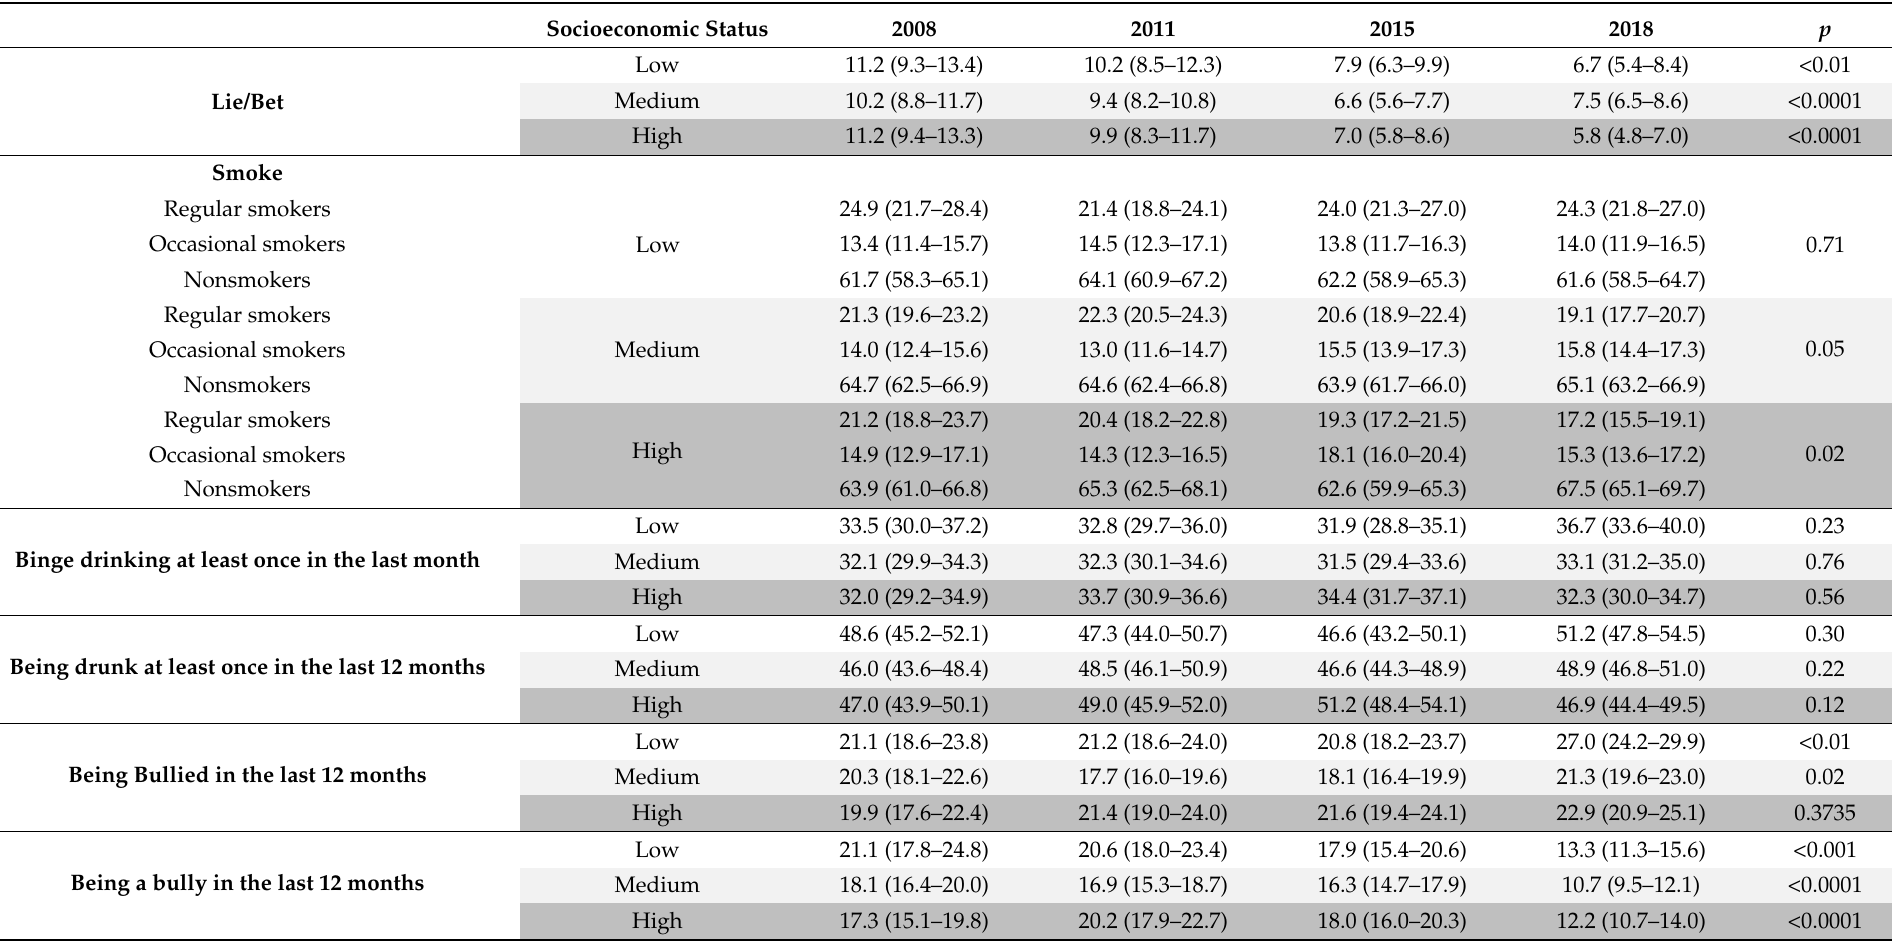
Table 5. Trends of the prevalence of health risk behaviors and health conditions by socioeconomic status (survey waves 2008, 2011, 2015, and